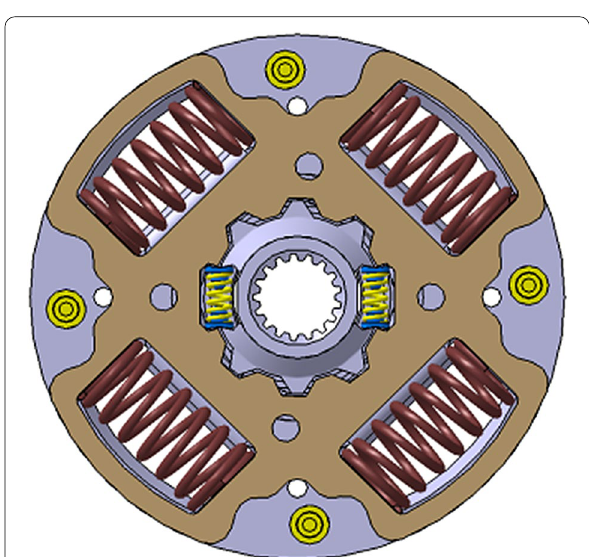
Figure 5 Schematic illustration of internal structure of traditional clutch